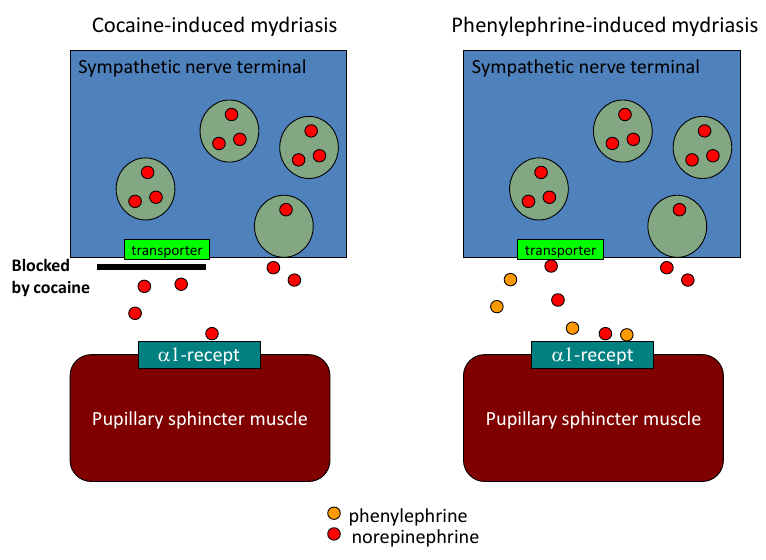
Figure 3. Pupillary mydriasis by cocaine and phenylephrine.